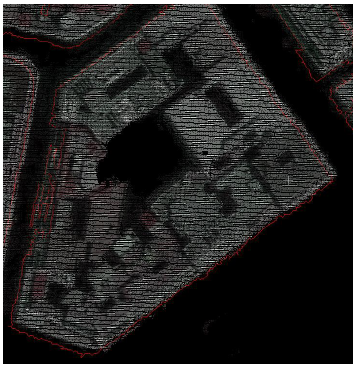
Figure 5: Complexes of buildings with terraces